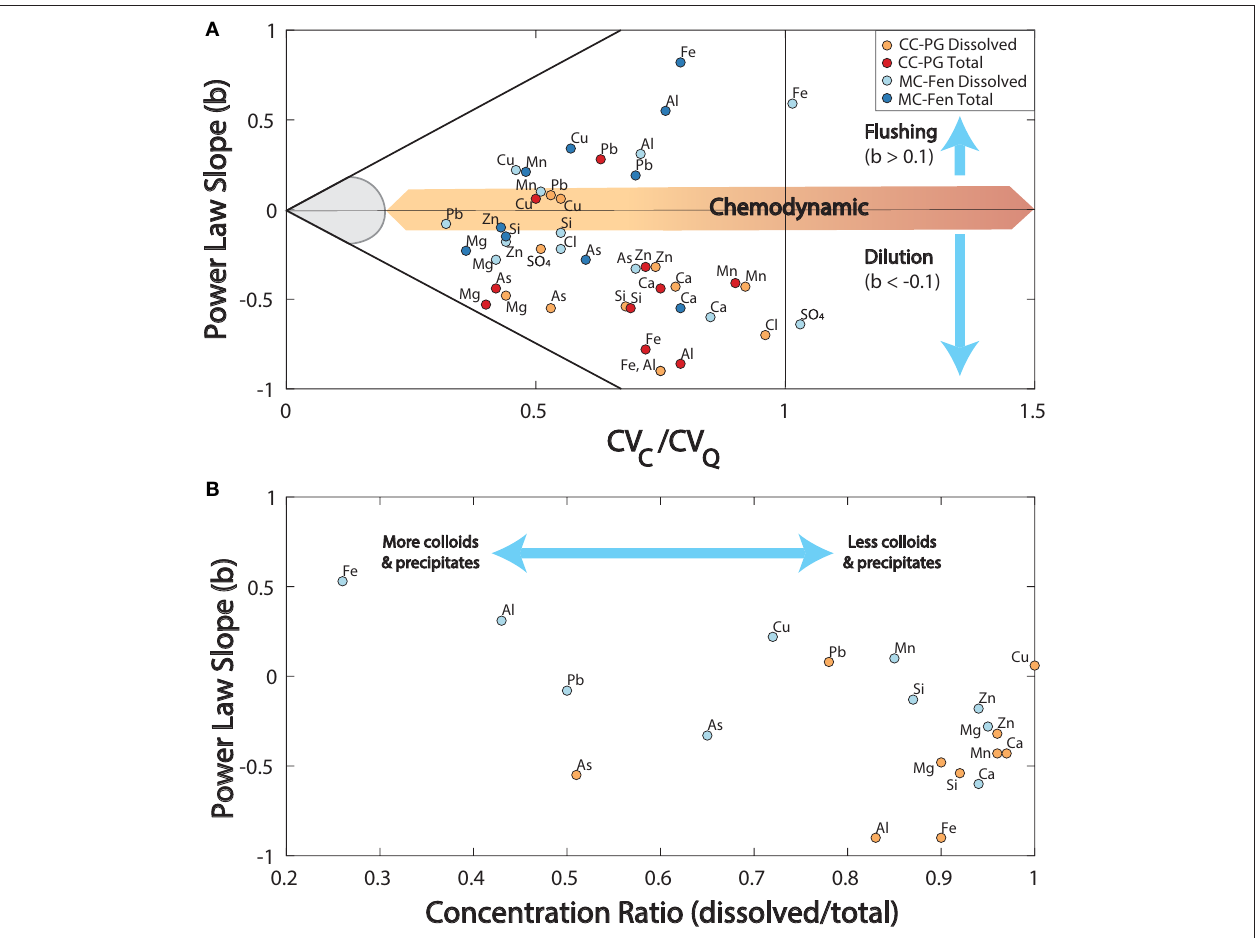
FIGURE 9 | (A) CV C / CV Q and power law slopes for redox-sensitive metals and major elements for the tracer study reaches and (B) power law slopes vs. the ratio of dissolved ( < 0.2 or < 0.45 µ m) and total (unfiltered) samples.